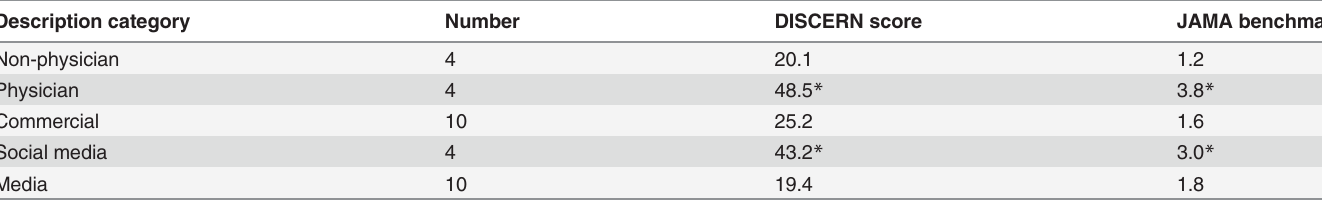
Table 5. Average DISCERN score and JAMA benchmark in each description